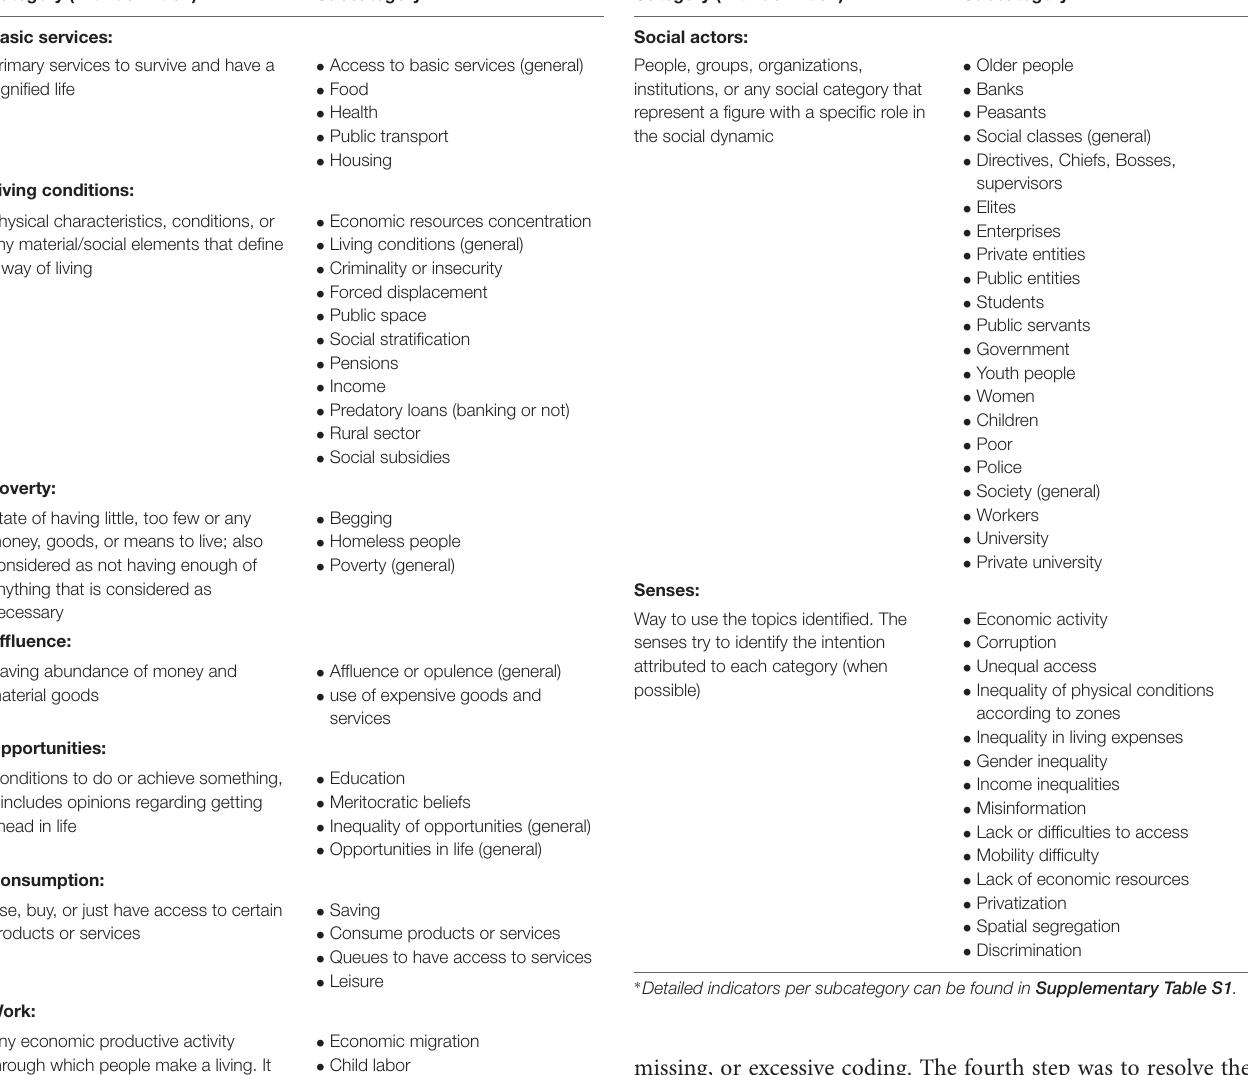
TABLE 1 | Categorical framework ∗ . Category (with definition)